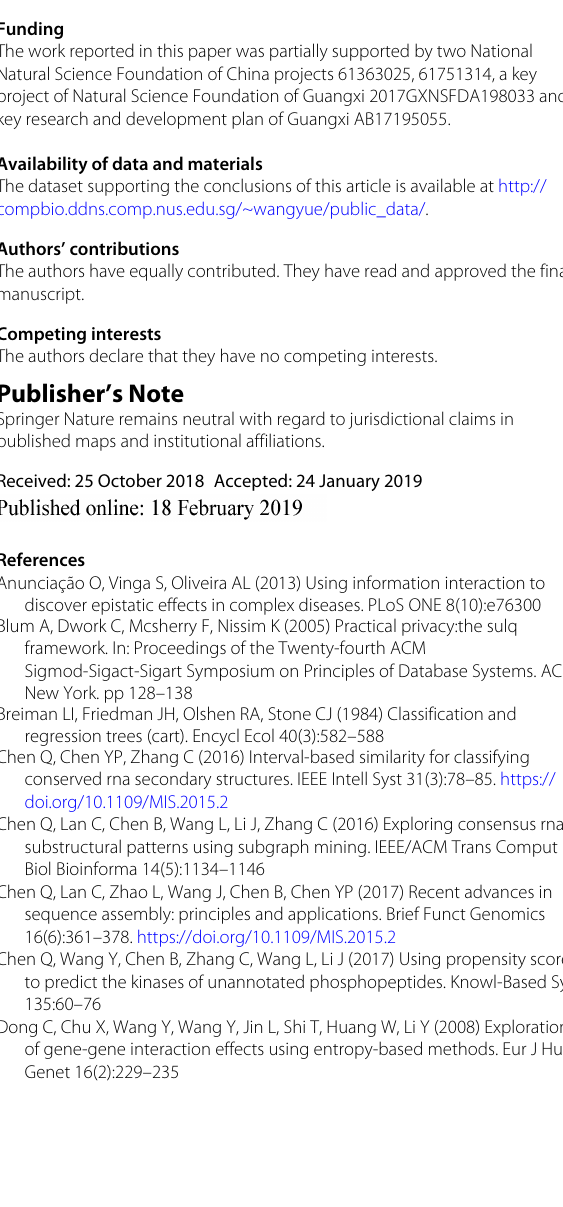
detected in other literatures as having a strong associa- tion with this disease. In addition, other loci are detected in this paper are rs912304, rs1161343. Although they have not been found to be associated with the disease in related works. According to the experimental results, they has a high possibility to be associated with the disease.